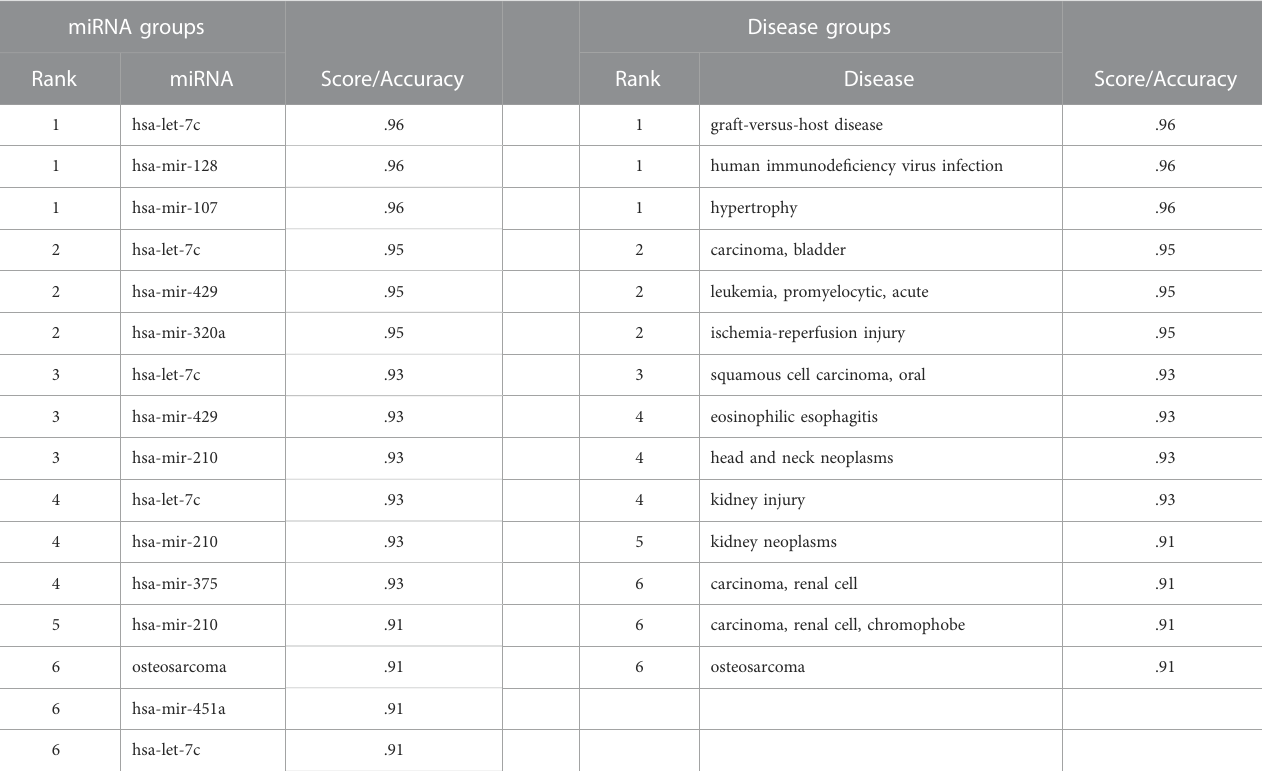
TABLE 5 An example of the fi rst six ranking groups with an accuracy of miRNA groups in BLCA and an example of the fi rst six ranking groups with accuracy of disease groups in BLCA. miRNA groups Disease groups